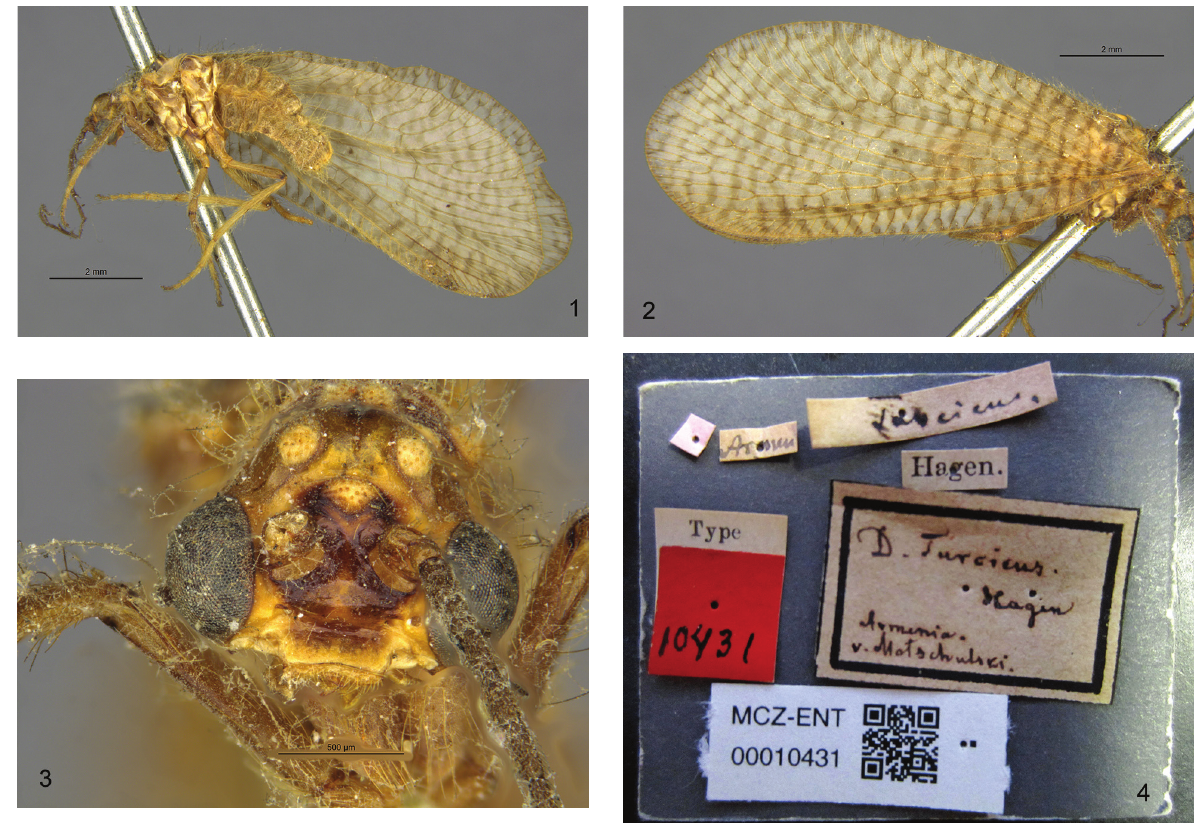
Figures 1–4. Dilar turcicus Hagen, lectotype, male (MCZ, Cambridge). 1. Habitus, lateral view from left; 2. Habitus, lateral view from right; 3. Head, frontal view; 4.